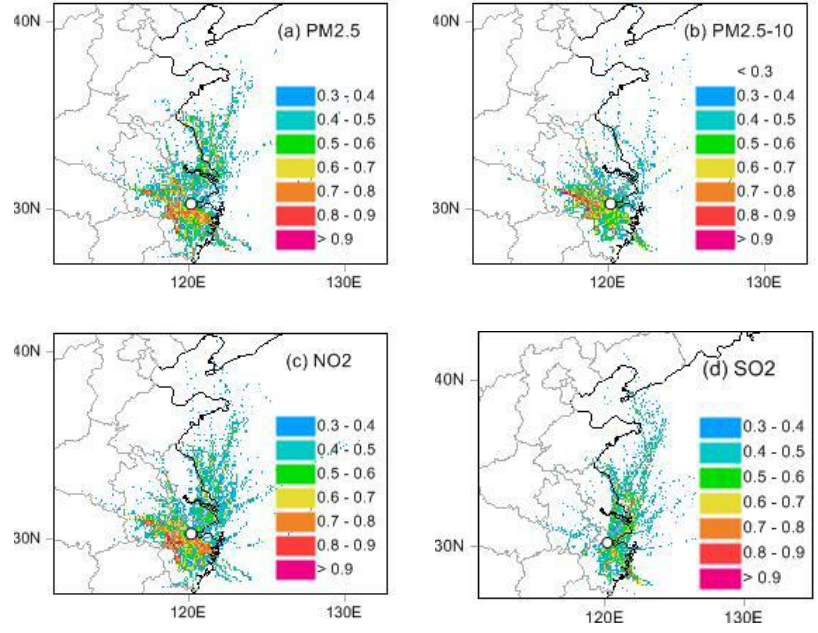
Figure 6. Potential source contribution function (PSCF) of PM 2.5 ( a ), PM 2.5–10 ( b ), NO 2 ( c ), and SO 2 ( d ) in Hangzhou. The sampling site is marked in circle and the PSCF values are displayed in color.